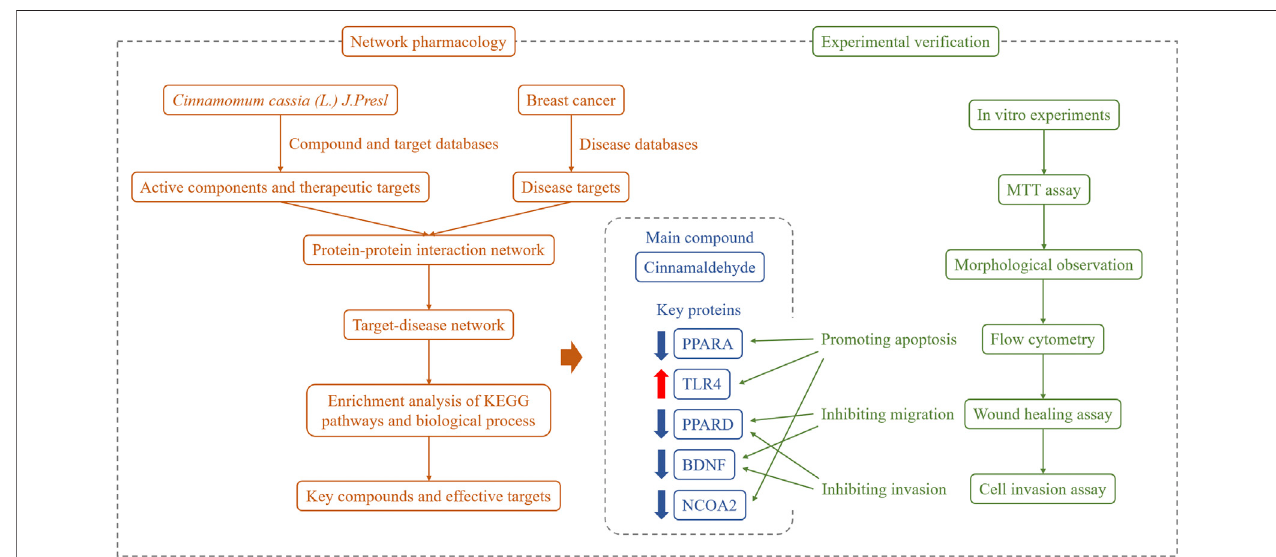
FIGURE10| Overallframeworkofcinnamaldehydeforthetreatmentofbreastcancer.Throughthenetworkpharmacologicalintegrationstrategy,cinnamaldehyde (themainchemicalcomponentofcinnamoninbreastcancer)wasselected.Basedon invitro cellexperiments,cinnamaldehydewascon fi rmedtopromotetheapoptosis of breast cancer tumor cells and inhibit cell migration and